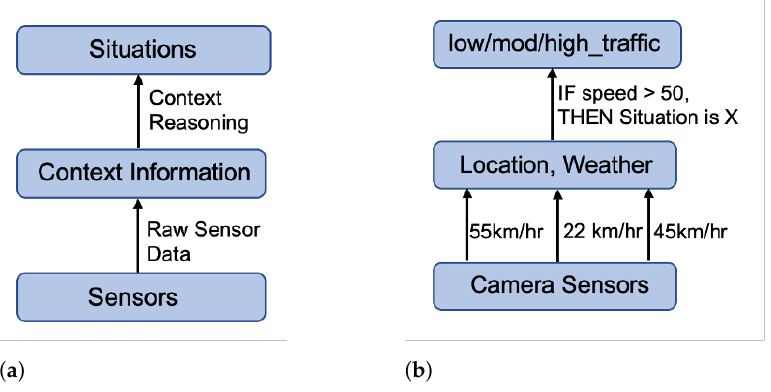
Figure 13. High-level overview of a traffic monitoring scenario: ( a ) concept, ( b )